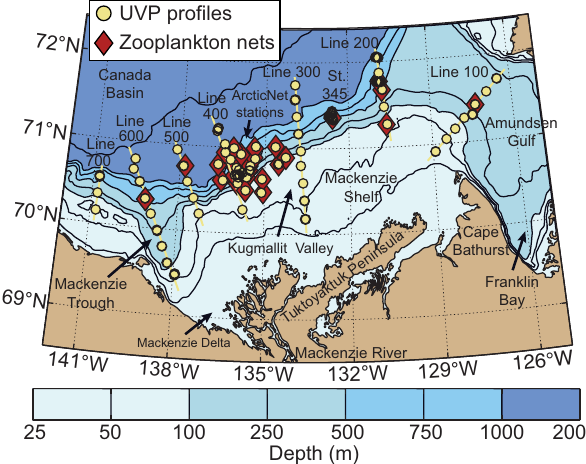
Fig. 1. Bathymetric map of the southeast Beaufort Sea (Arctic Ocean) with position of the sampling stations conducted in July– August 2009 as part of the successive ArcticNet and Malina cam- paigns. The ArcticNet sampling sites were located in the explo- ration license area EL446, whereas transects 100–700 and station 345 correspond to the Malina sampling grid. The shelf, slope and basin regions as defined in the present study correspond to the sampling stations located within the < 100m, 100–1000m and > 1000m isobaths, respectively. The metadata (coordinates, date, sampling type) for each oceanographic station are detailed in the Appendix